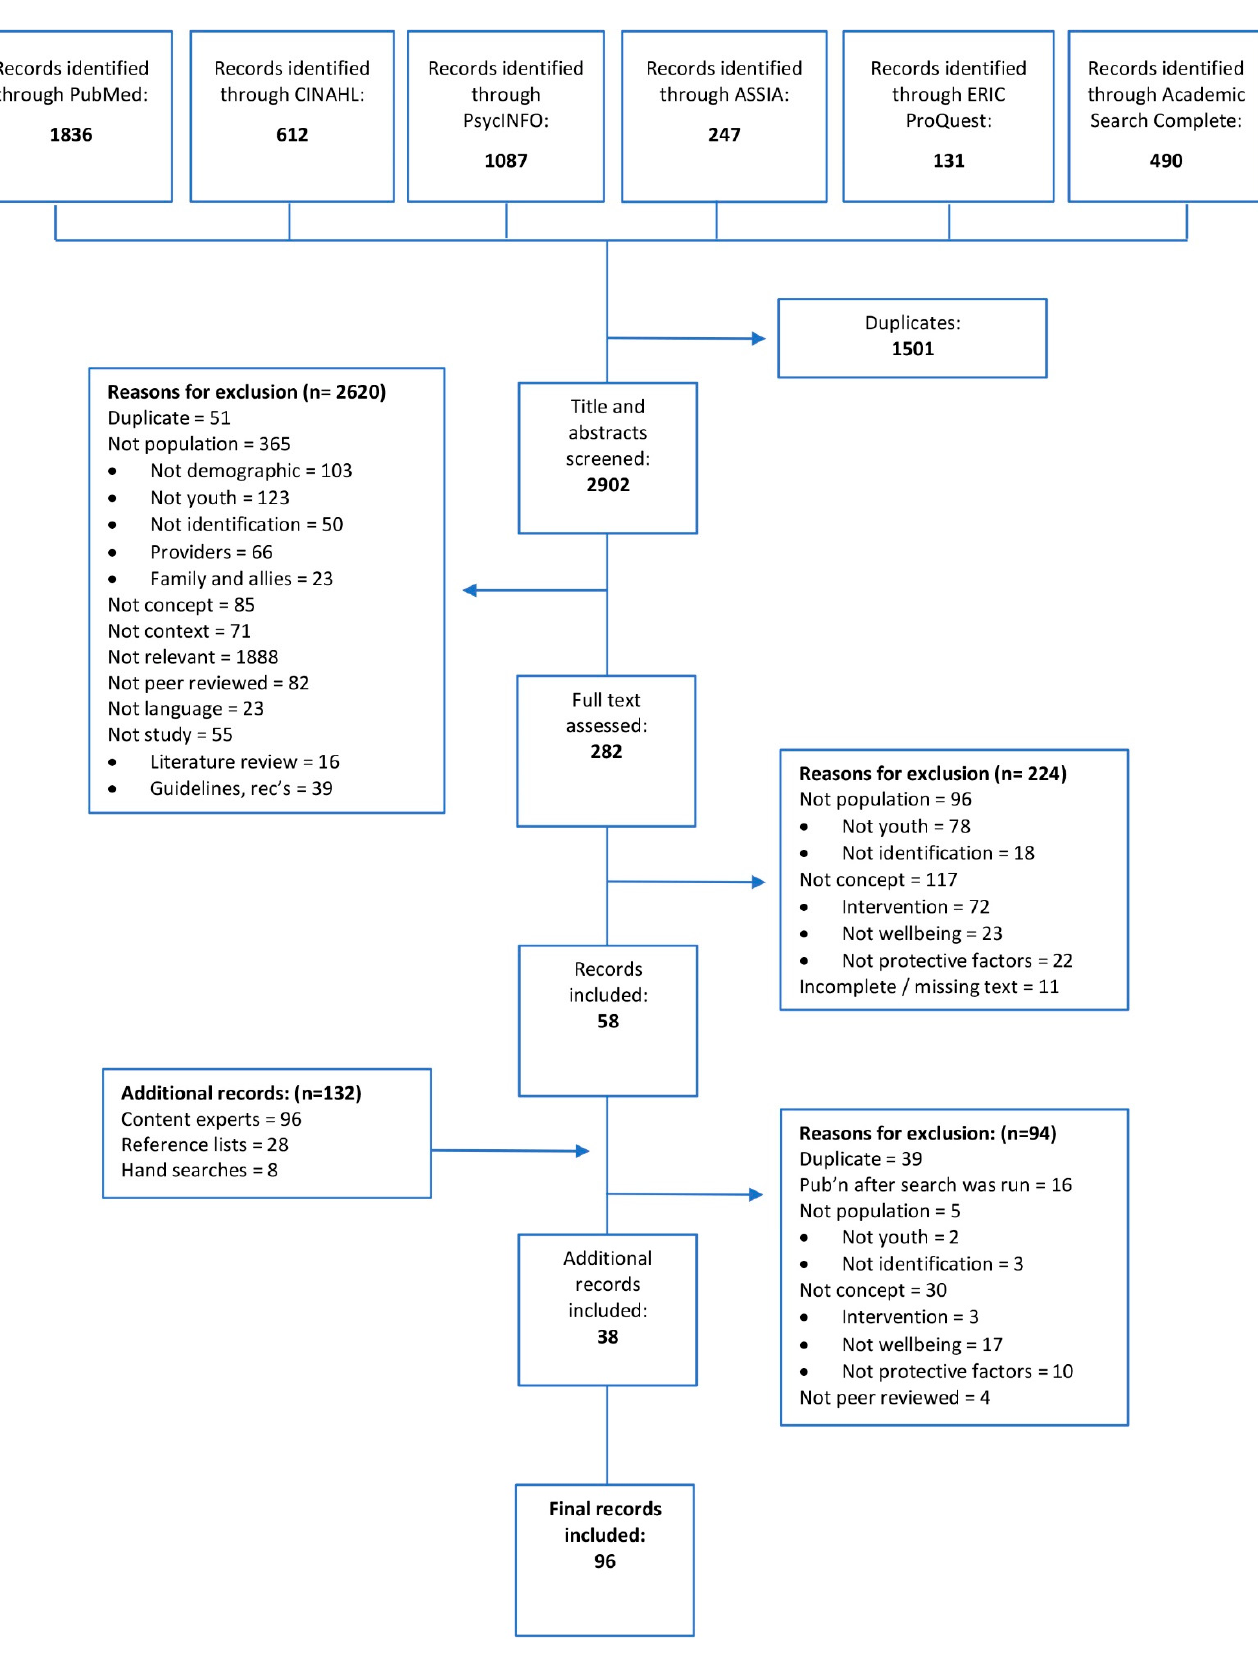
Figure 1. Screening and filtering process.